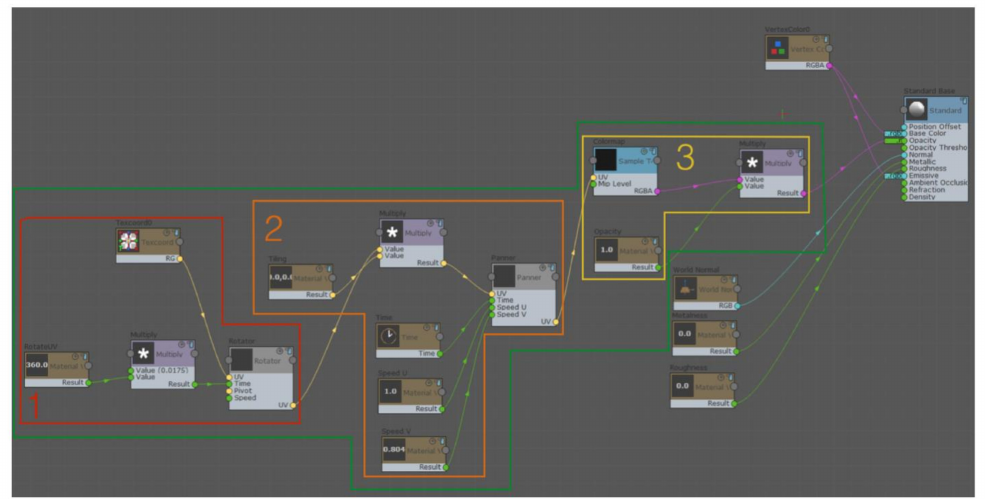
Figure A1. CFD animation material script in 3ds Max for wind flow animation.